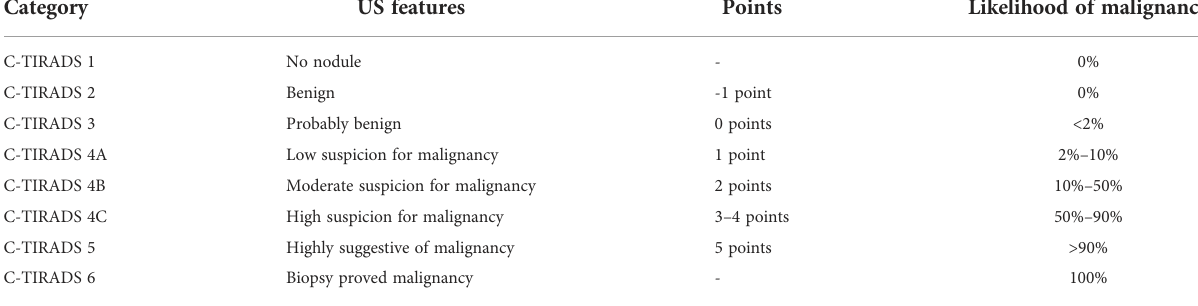
TABLE 1 C-TIRADS malignancy risk strati fi cation of thyroid nodules.